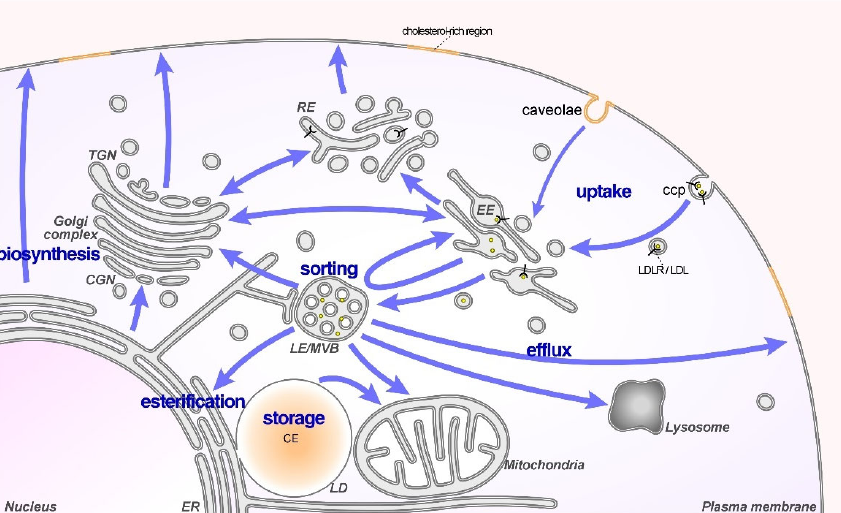
Figure 1. Late endosomes/multivesicular bodies (LE/MVB) are the hub for the cellular distribution of cholesterol. LDLR-mediated endocytosis delivers LDL-derived cholesterol to LE/MVB from where cholesterol is distributed via Niemann–Pick type C1/2 (NPC1/2) proteins and other transporters to the ER, mitochondria, Golgi and plasma membrane. The cellular transport routes of cholesterol are indicated. Abbreviations: CE, cholesteryl ester; ccp, clathrin-coated pit; EE/RE, early/recycling endosomes; ER, endoplasmic reticulum; LD, lipid droplet; LDL, low-density lipoprotein; LDLR, LDL receptor; MVB, multivesicular bodies; TGN, trans-Golgi